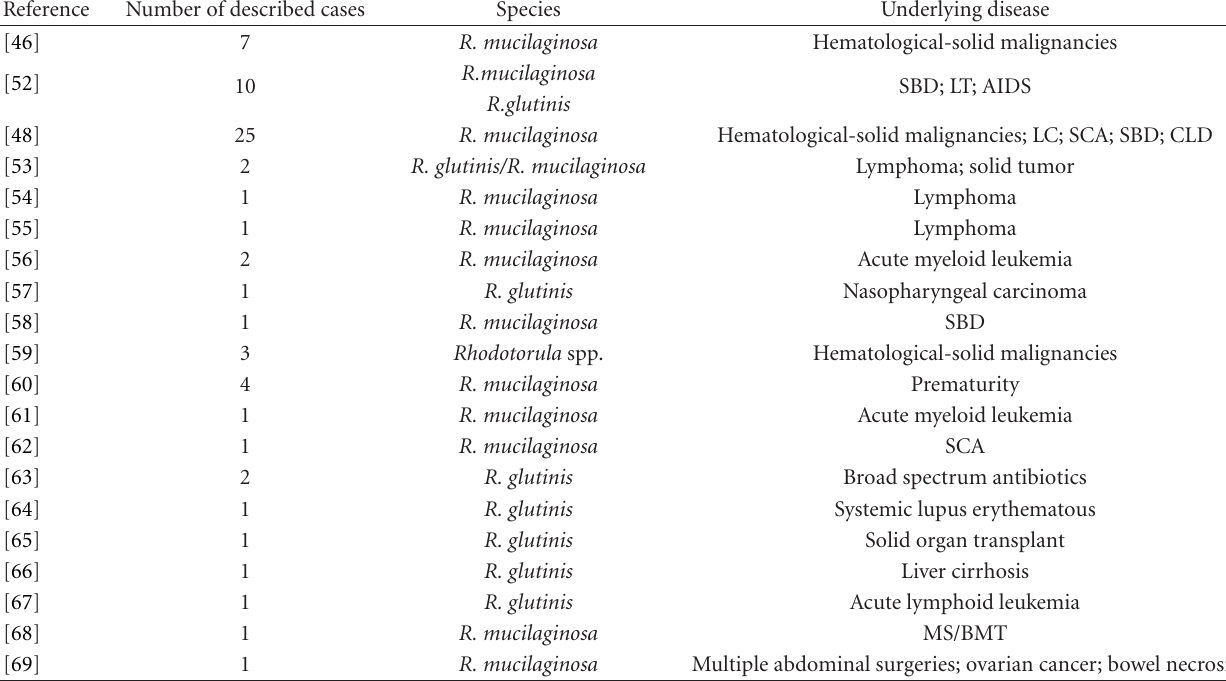
BMT:bone marrowtransplant; CLD: congenital liver disease; LC: liver cirrhosis; LT: lung transplant; MS: myelodysplastic syndrome;SBD: short bowel disease; SCA: sickle cell anemia; SOT: solid organ